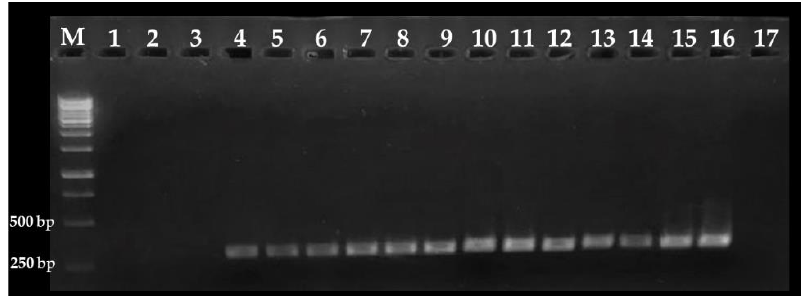
Figure 2. Detection limit of the Cyclospora cayetanensis nested PCR assay. Lanes 1 to 3: non-spiked blueberries; lanes 4 to 6: samples spiked with ~1 oocyst per gram of sample; lanes 7 to 9: samples spiked with ~10 oocysts per gram of sample; lanes 10 to 12: samples spiked with ~100 oocysts per gram of sample, and lanes 13 to 15: samples spiked with ~1000 oocysts per gram of sample. Lane 16: C. cayetanensis DNA as positive control and lane 17: water PCR grade as negative control. Fifty grams of blueberries were used for each sample. M: molecular weight marker.